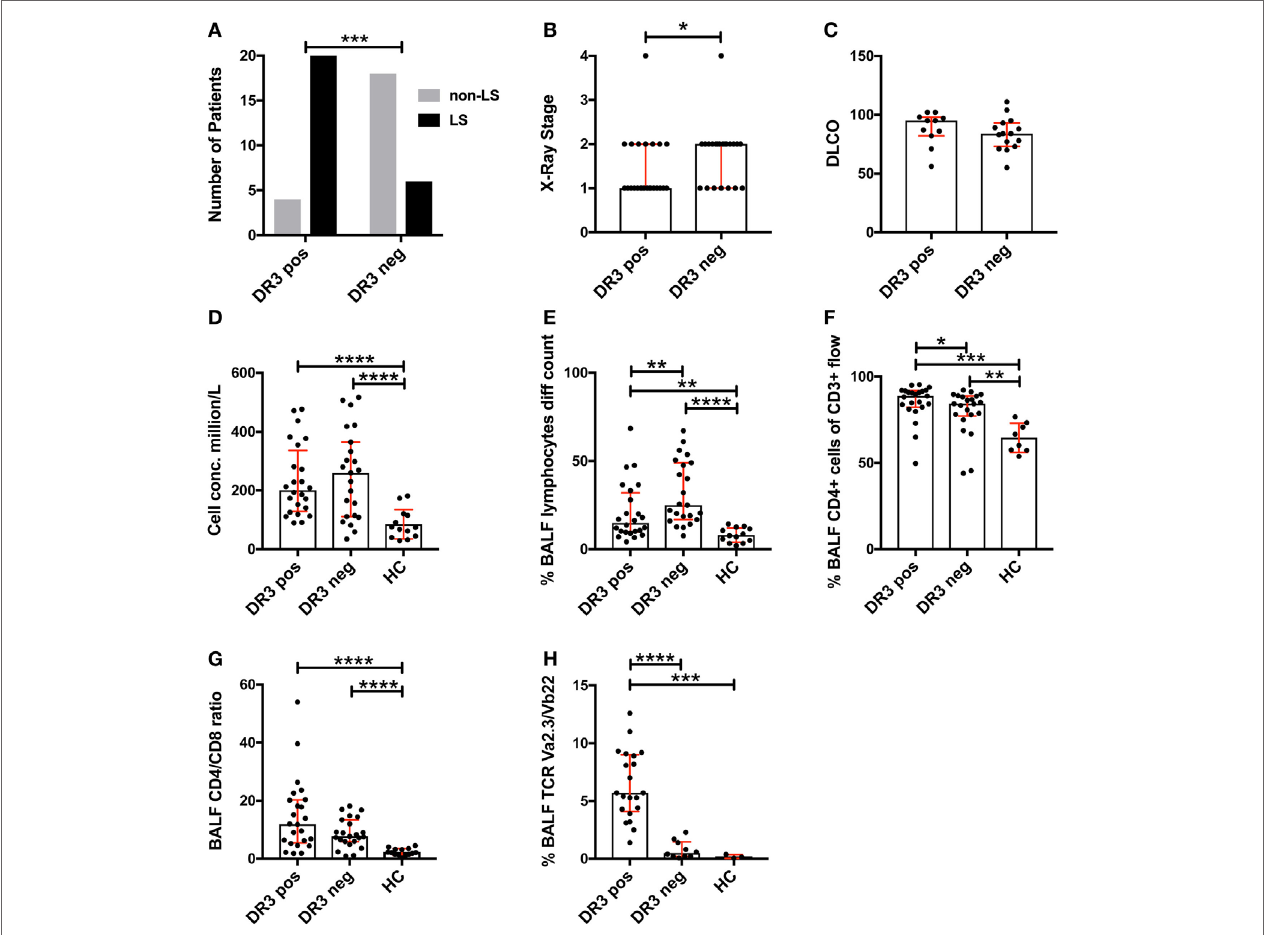
FigUre 1 | Differences in lung characteristics of HLA-DRB1*03 positive and negative patients and healthy controls. Analysis of clinical characteristics and bronchoalveolar lavage fluid (BALF) parameters of the study cohort was performed according to standard diagnostic routines. Frequency of Löfgren’s syndrome (LS) and non-LS, respectively, in patients positive or negative for HLA-DRB1*03 was determined by Fischer’s exact test (a) following HLA typing and independent verification of diagnosis by at least two pulmonary specialists. Similarly, differences in chest radiographic stage (B) and DLCO (c) were assessed using standard clinical measurements. BALF cell measurements (D–h) were performed by ex vivo cell count (D,e) and flow cytometric analysis (F–h) following separation of cells and fluid by centrifugation. Comparisons between groups were performed using the non-parametric Mann–Whitney U test and all values are presented as median with interquartile range. Statistically significant differences between groups are indicated as two-tailed p -values according to the following scheme: * p < 0.05; ** p < 0.01; *** p < 0.001; and **** p <